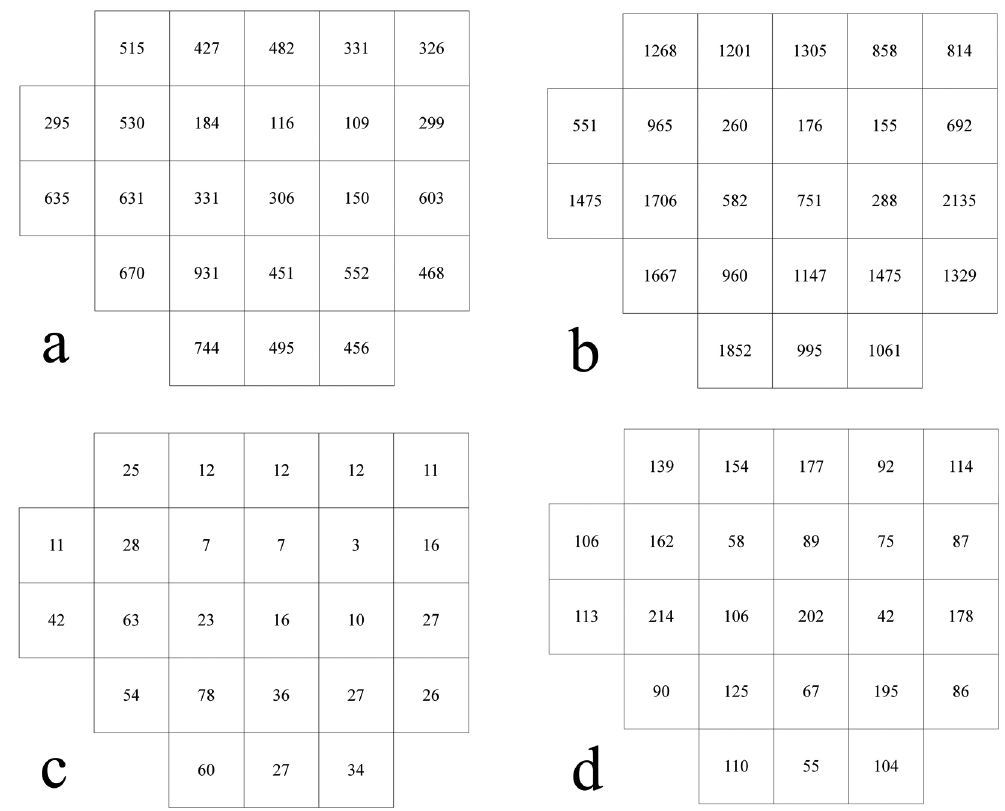
Fig. 3. The number of (a) plant species, (b) herbarium records, (c) declared rare and priority plant species and (d) all vertebrate species recorded in half degree grid cells across the study